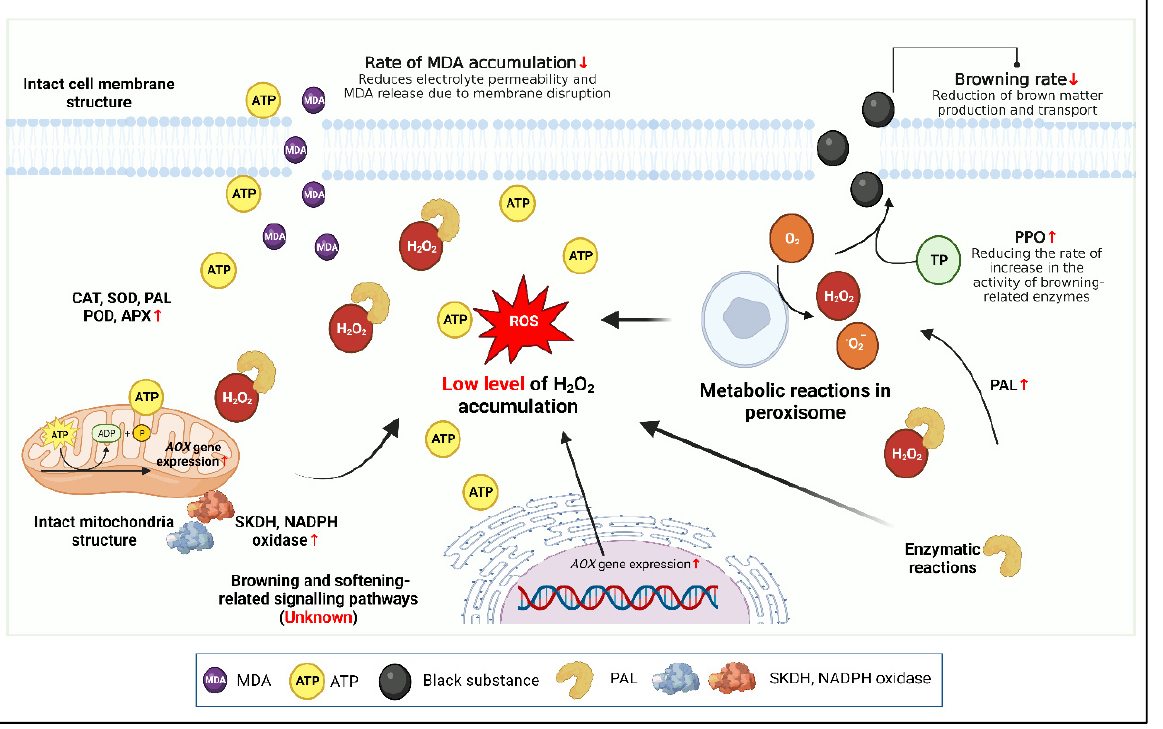
Figure 6. Application and mechanism of action of exogenous energy substances in the preservation of edible mushrooms. Created with BioRender.com. of edible mushrooms. Created with